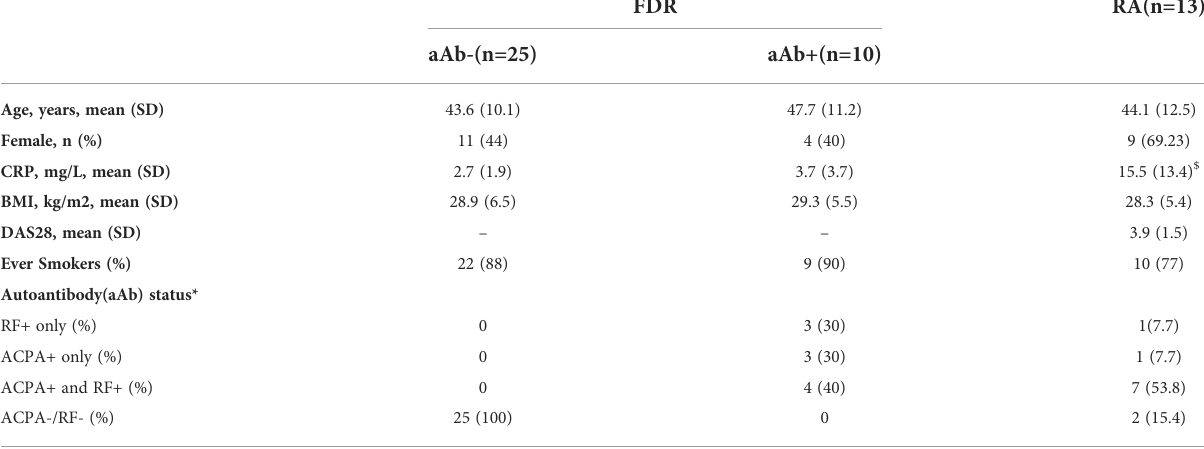
TABLE 1 Baseline characteristics of the study population: All values are reported as either mean (SD) or n